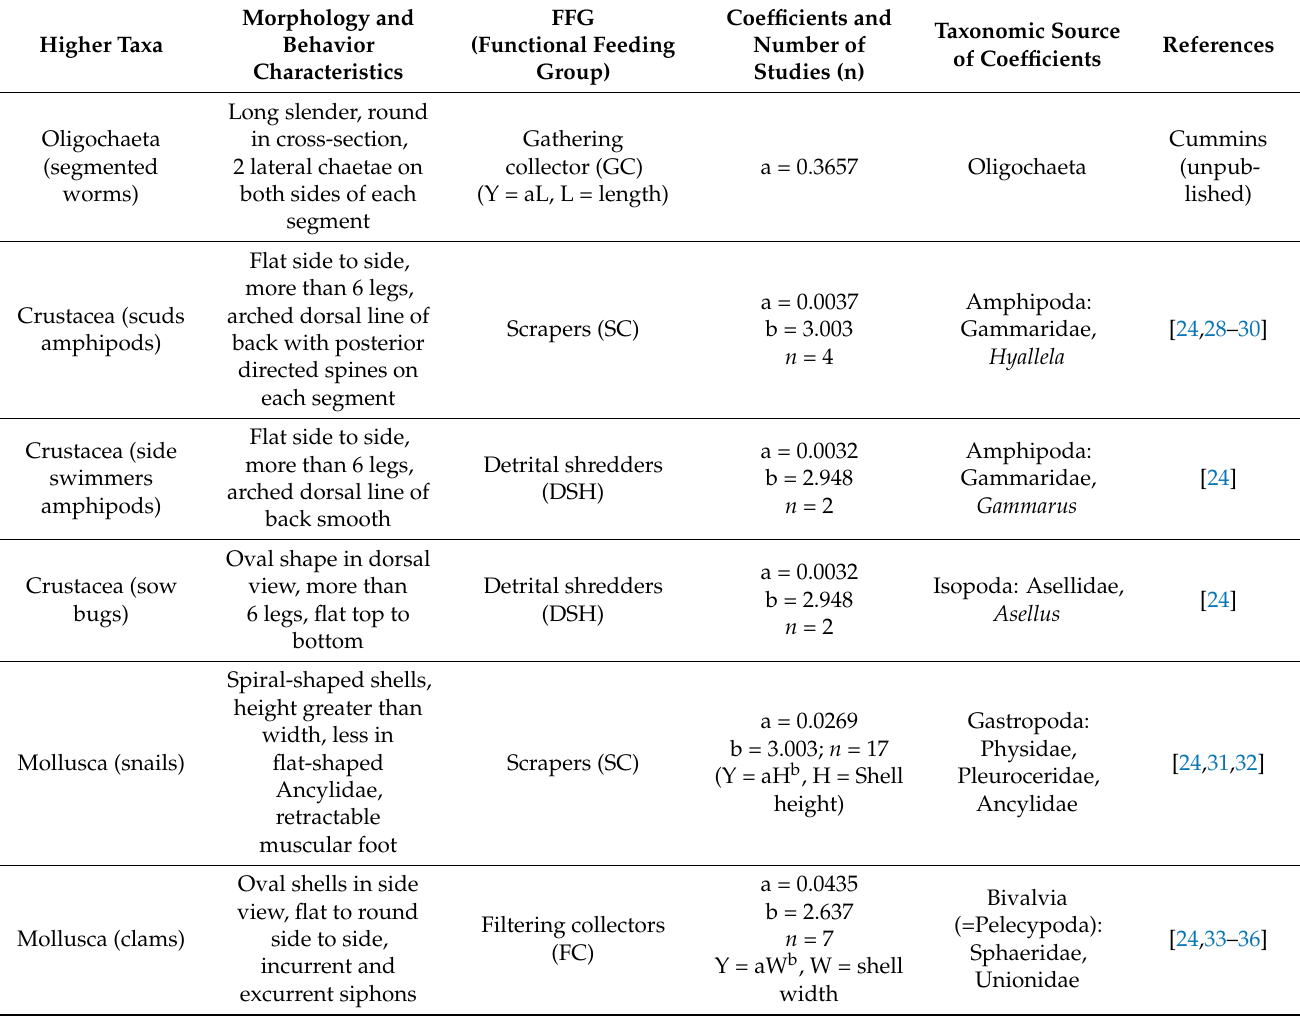
Table 2. Intercept and slope coefficients used in the regression equation Y = aX b where Y = dry biomass in mg; X = total body length in mm; a = intercept of Y on X; and b = slope of Y on X, organized by the macroinvertebrate taxa and functional feeding groups (FFGs) of stream macroinvertebrates. Coefficients were averaged from regressions used in the study by Cummins (unpublished) and from the representative literature. All insect body lengths, in mm, were measured from the front of the head to the end of abdomen, excluding filaments and head appendages: for Oligochaeta, L = mm body length; Mollusca, Gastropoda H = shell height; Mollusca, Bivalvia W = shell width, H = shell